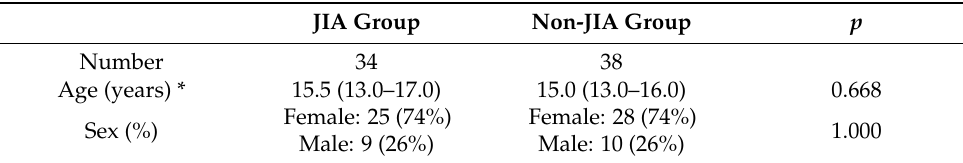
Table 1. Comparison between JIA and non-JIA patients.